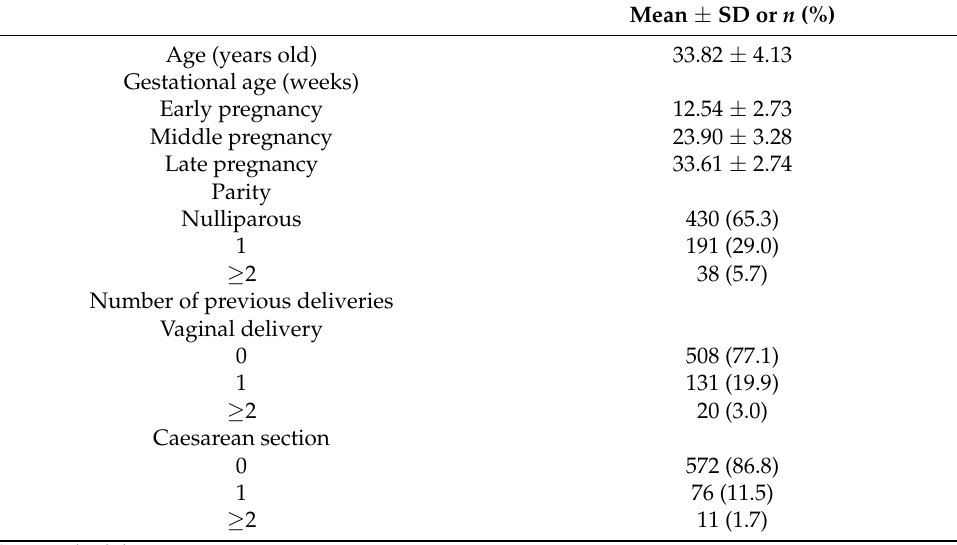
Table 2. Characteristics of participants during early